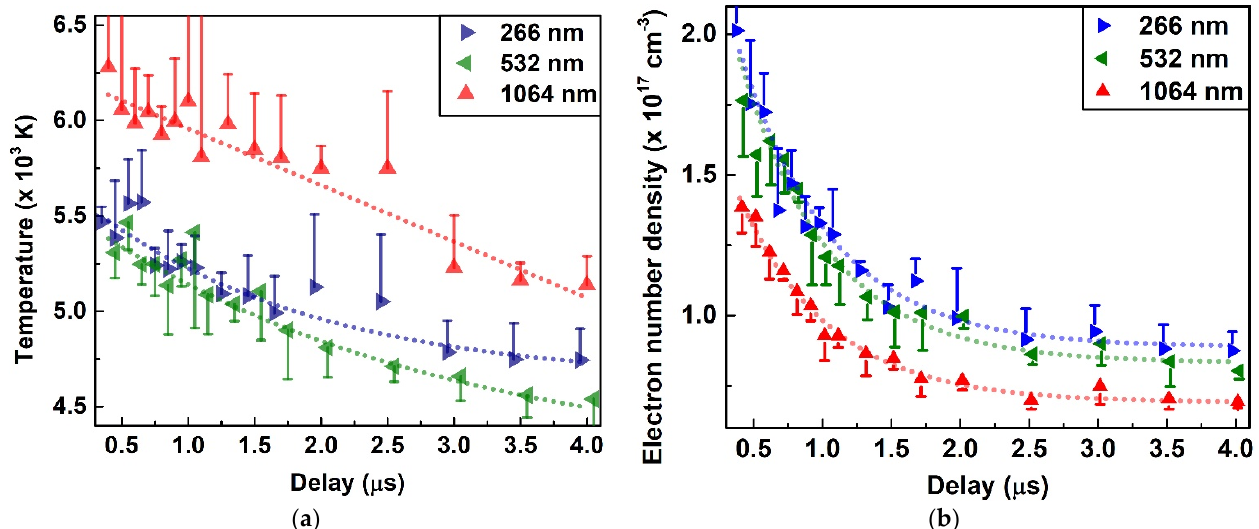
Figure 8. Plasma temperature ( a ) and electron number density ( b ) as a function of delay time from 0.4 µs to 4.0 µs. The half-y-axis error bars are shown for clarity and x-axis error bars are not shown for the same reason.